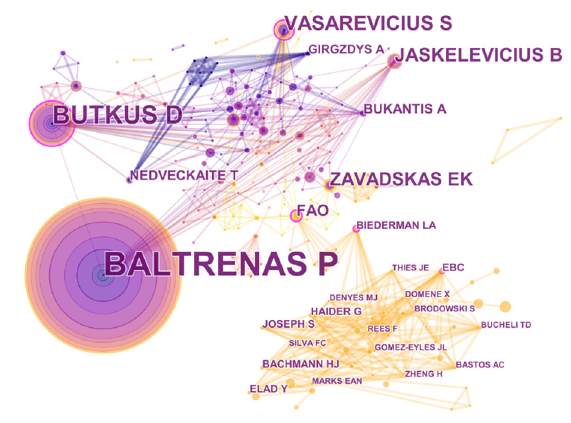
Figure 7. A visualization of the author co-citation